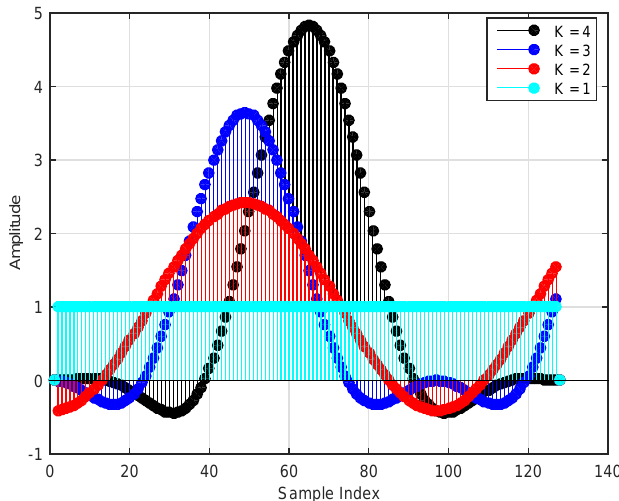
Figure 17. Plot of filter impulse response for different overlapping factor K , M =